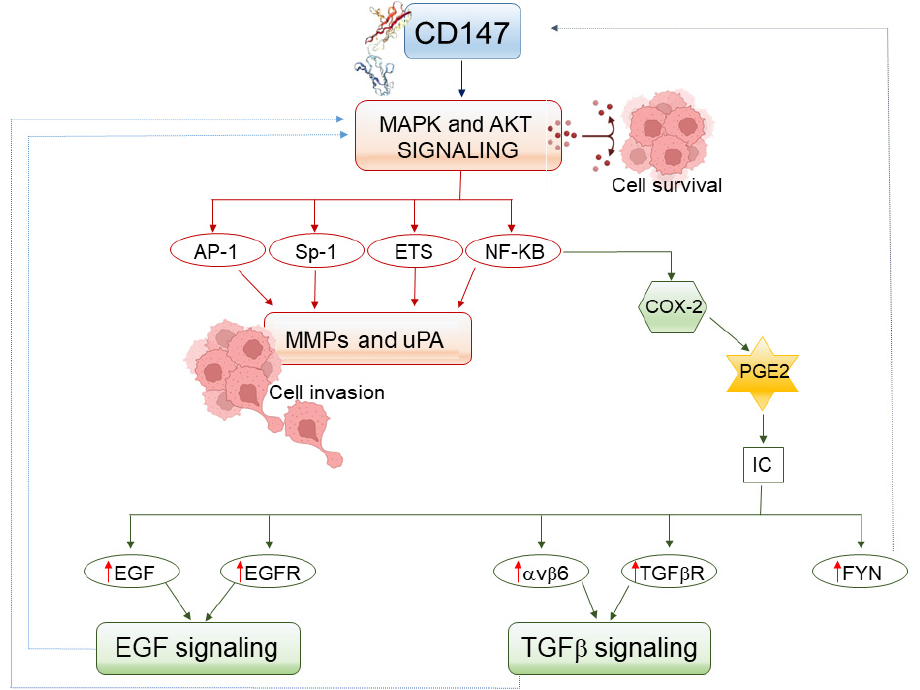
Figure 1. CD147 triggering leads to the expression and/or functional activation of proteolytic enzymes, inflammatory mediators, and growth factors with a key role in oral carcinogenesis. Arrows symbolize directions of connections. Abbreviations: AKT, protein kinase B; AP ‐ 1, Activator Protein ‐ 1; COX ‐ 2, cyclooxygenase ‐ 2; EGF, epidermal growth factor; EGFR, epidermal growth factor receptor; IC, inflammatory cytokines; MAPK, mitogen ‐ activated protein kinase; MMP, matrix metalloproteinase; NF ‐ kB, Nuclear Factor ‐ kappa B; PGE2, prostaglandin E2; Sp ‐ 1, Specificity protein ‐ 1; TGF β , transforming growth β ; TGF β R, transforming growth β receptor; uPA, urokinase ‐ like Plasminogen Activator.